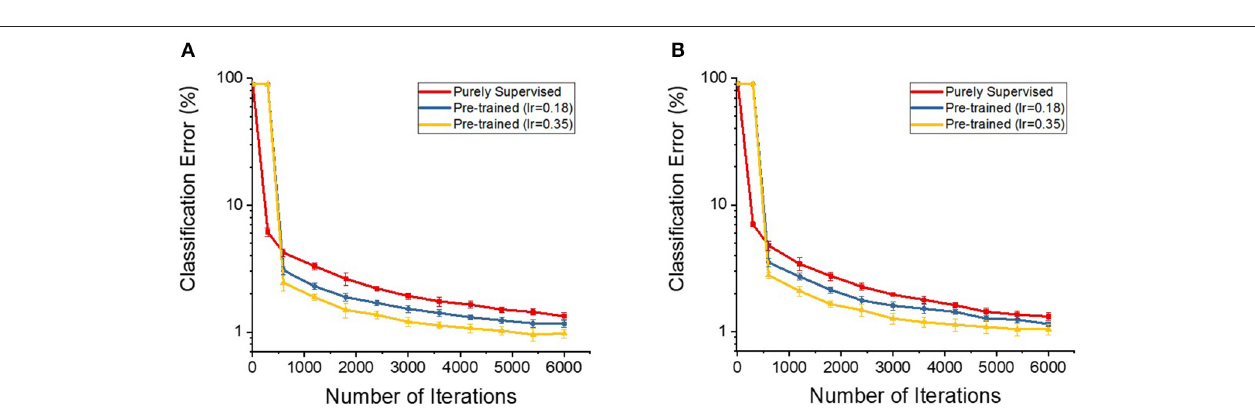
FIGURE 6 | The weight kernels of (A) purely supervised and (B) pre-trained model in first convolutional layer.